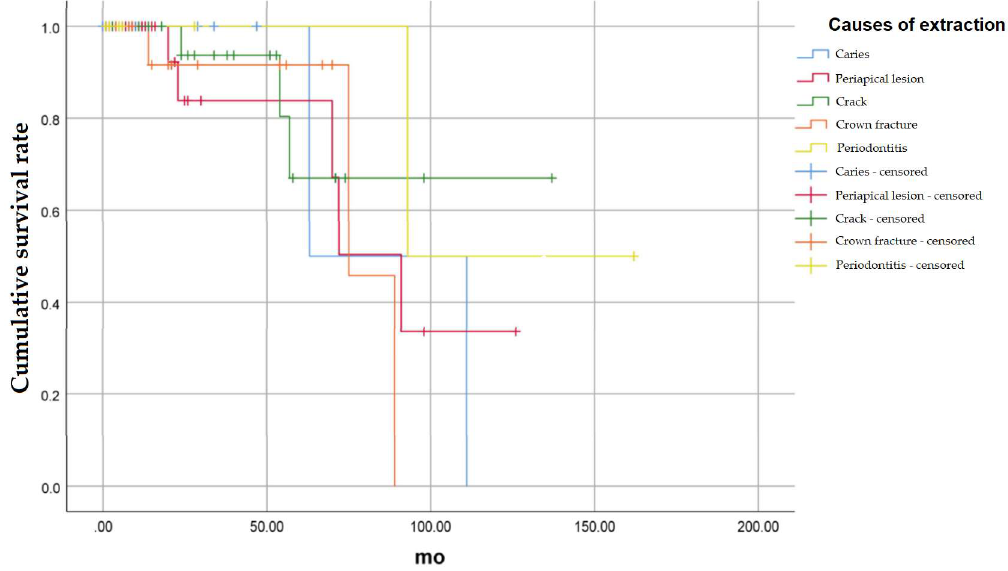
Figure 3. Cumulative survival rate of auto-transplanted tooth according to the cause of extraction of the recipient teeth. the recipient